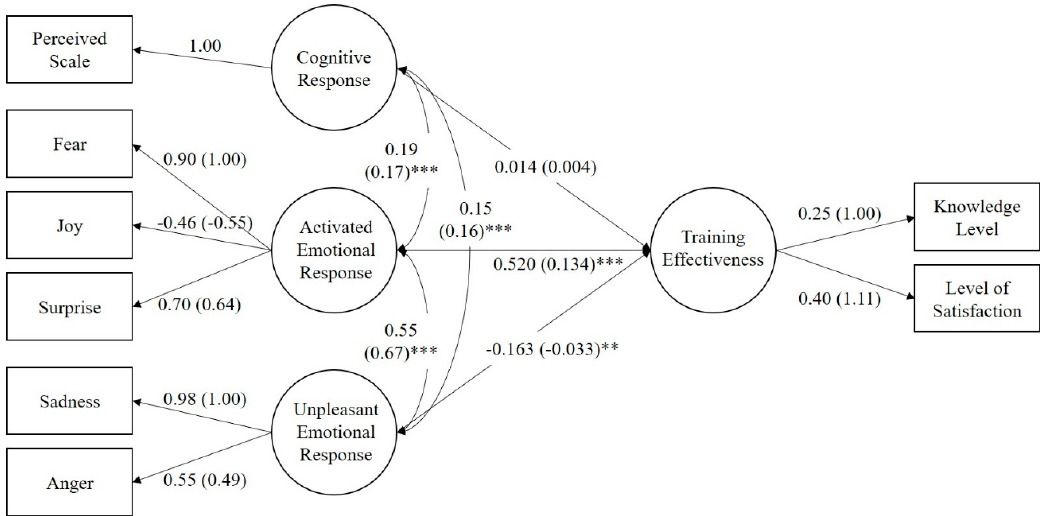
Figure 5. Causal Structural Equation Model (SEM) Diagram Showing Educational Effectiveness by Cognitive Response and Emotional Response with standardized path loading (estimate path loading).